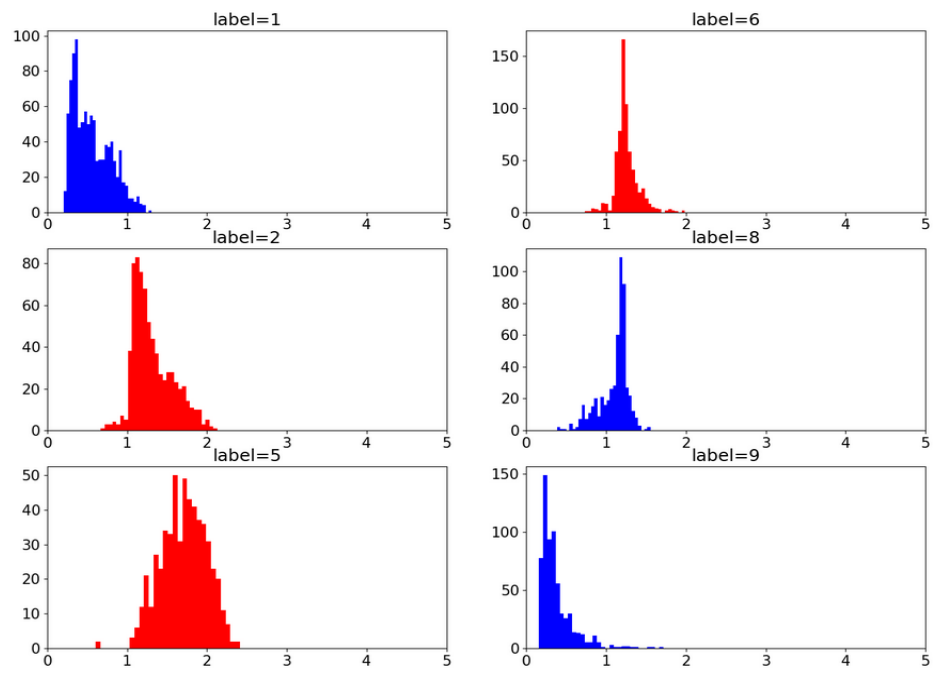
Figure 5. Obstruction task: Transfer-relevant (outlier) target instance histograms are depicted in red (blue). The figure is best viewed in color.